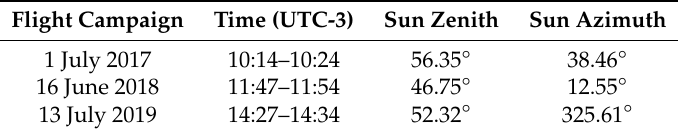
Table 4. Details of the image acquisition in each flight